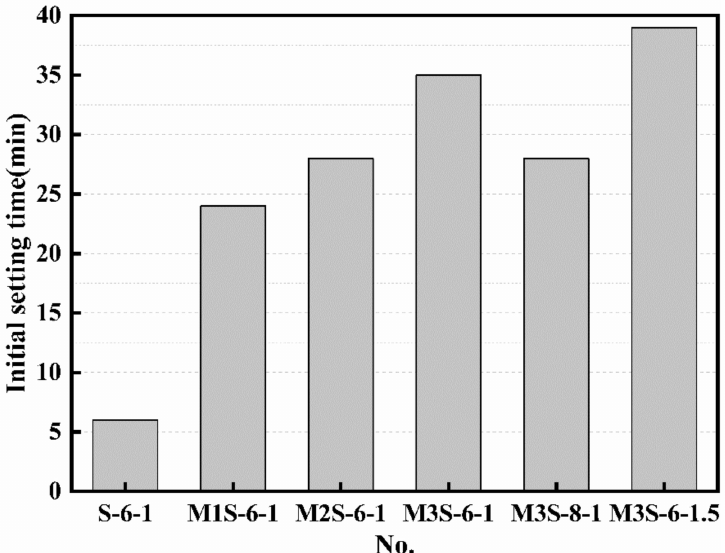
Figure 5. Initial setting time of alkali-activated slag with different metakaolin contents, activator modulus, and Na 2 O